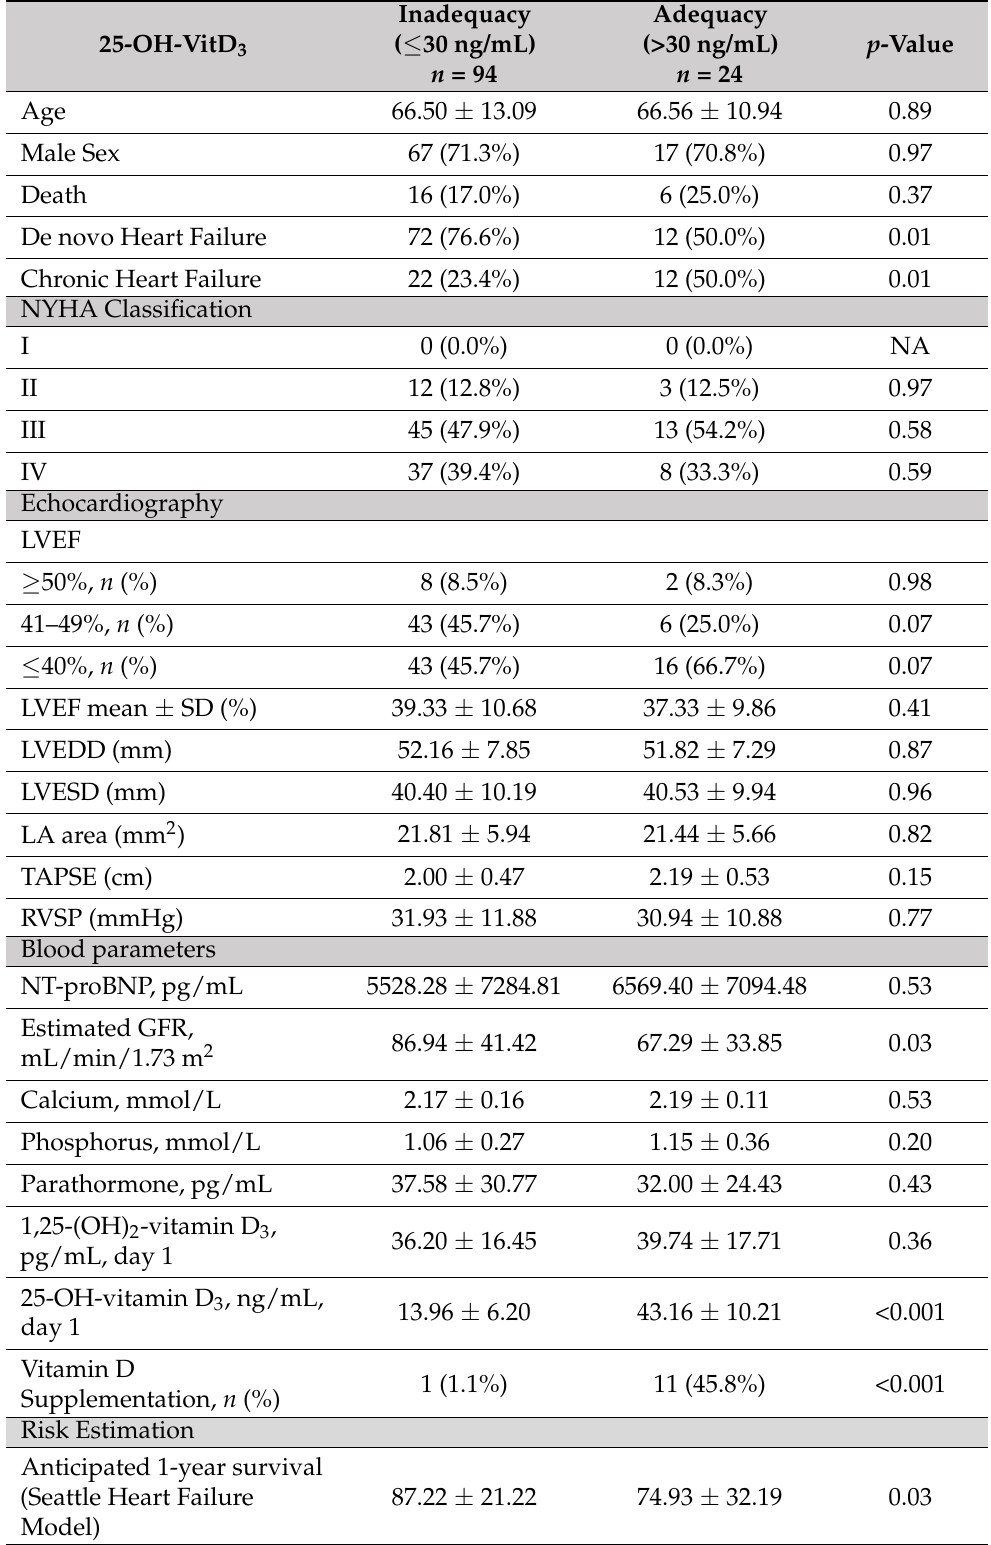
Table 2. 25-OH-vitamin D 3 levels in HF patients ( n =